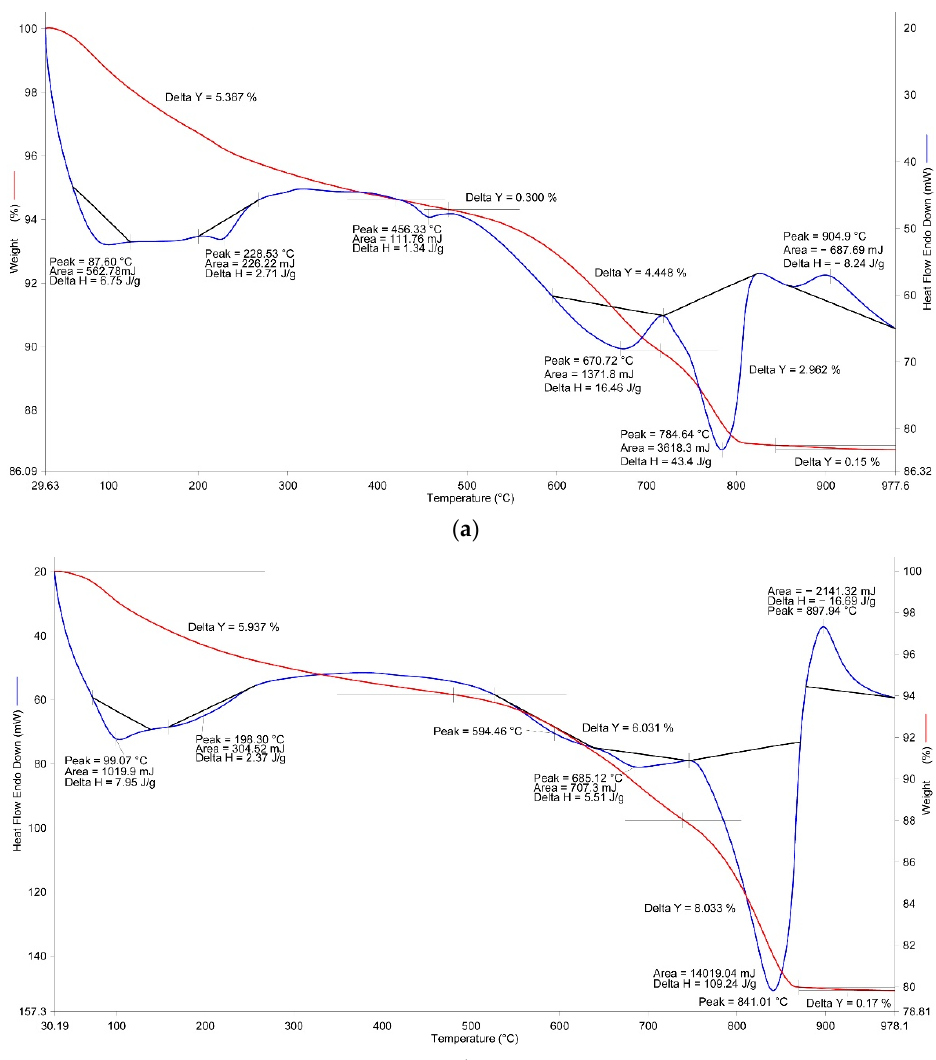
Figure 5. Results of the TG-DSC analysis of the HH ( a ) and MH ( b ) samples.